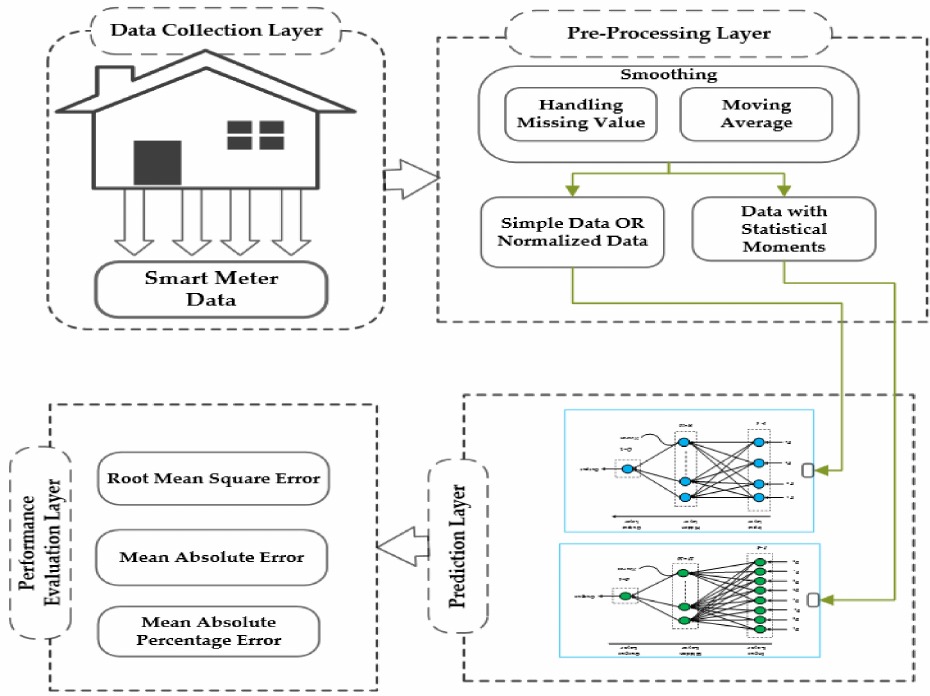
Figure 1. Proposed